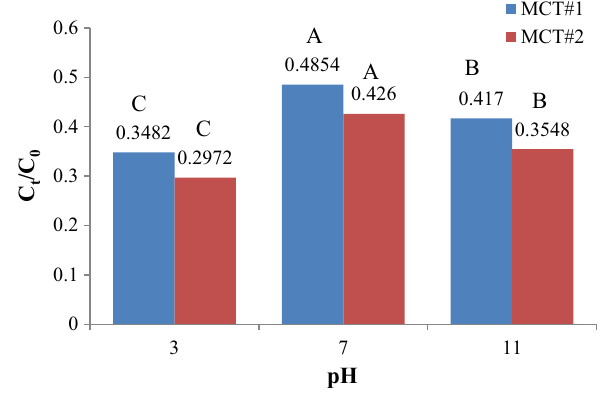
Fig. 9 Investigation of destruction rate changes of MO with pH (at constant irradiation time) using MCT#1 and MCT#2 based on Dun- can’s multiple range test at α =